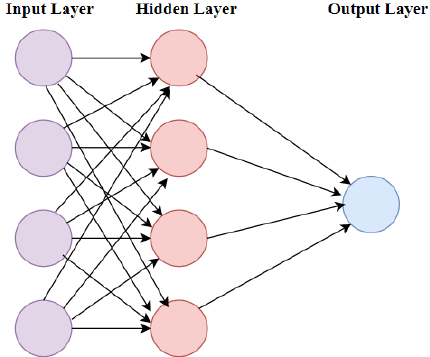
Figure 3. MLP algorithm